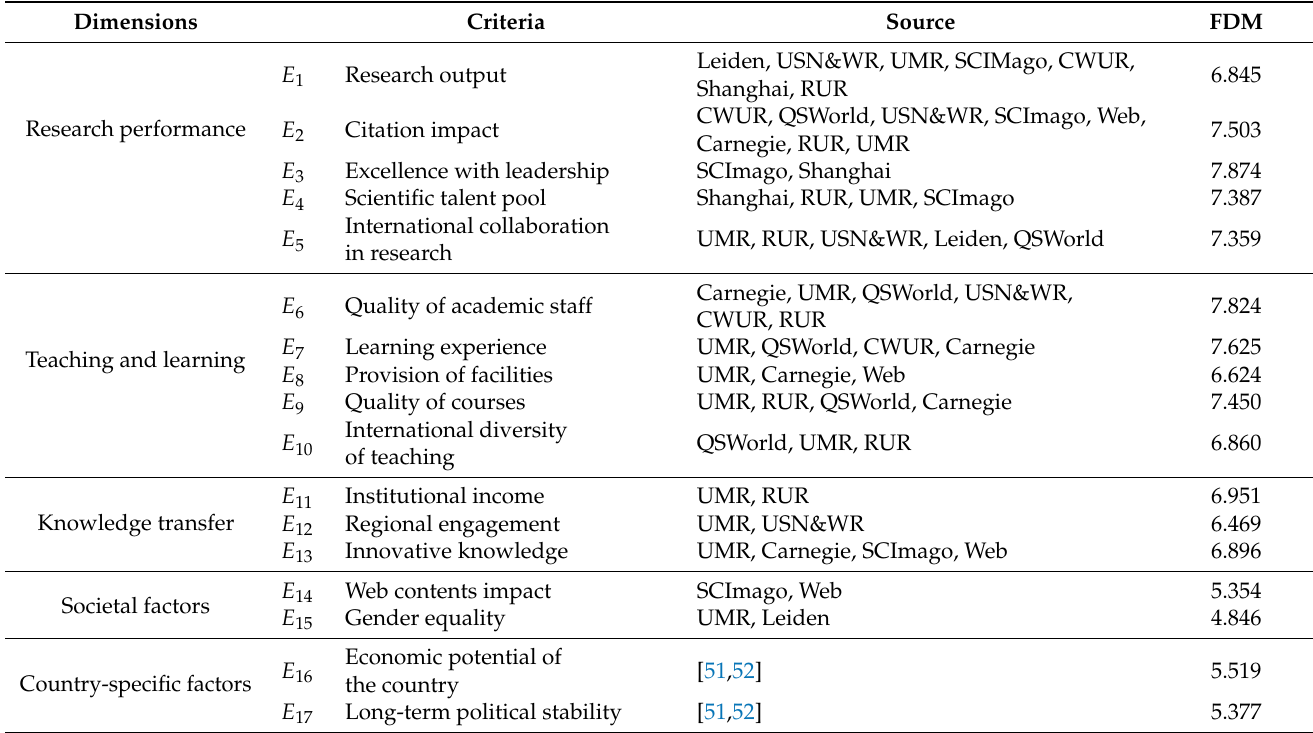
Table 1. Predetermined list of